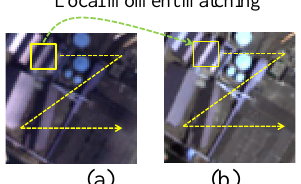
Figure 2. Schematic diagram of sliding window based local moment matching for thin cloud and light cloud shadow removal. (a) Target image with cloud shadows. (b) Auxiliary